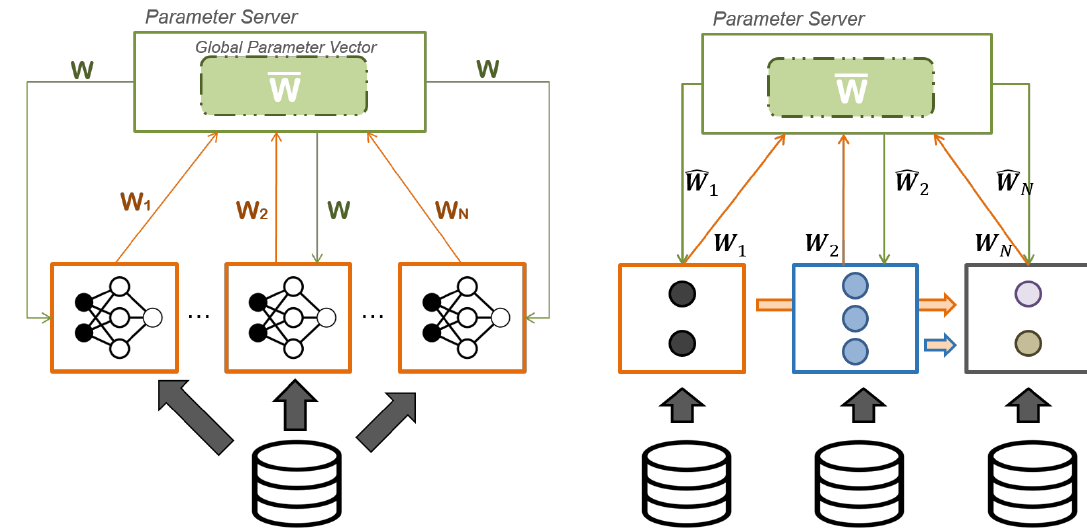
Figure 3. Data (left) and model (right) parallelization schemes. W i indicate the network weights associated with each worker i while ¯ W indicates the process of averaging the weights collected by all workers at the parameter server. For tee case of data parallelism, once the averaging is executed, the same weights W are distributed to all workers. For the case of model parallelism, each worker obtains the portion of weights ˆ W i corresponding to its local section of the network.